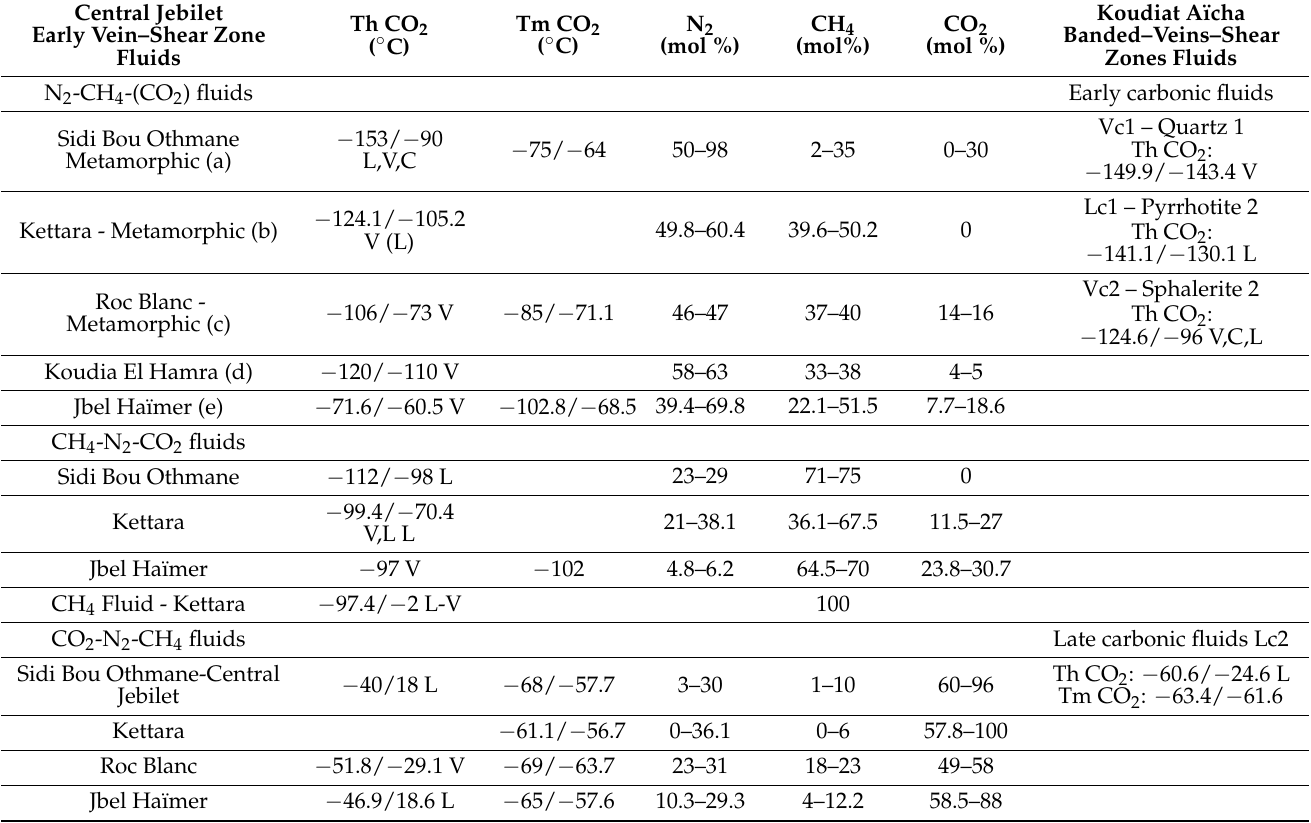
Table 5. Comparison of microthermometric data for fluid inclusions from early vein stages at Koudiat Aïcha (stage II) with data for C-O-N-H fluid inclusions from metamorphic veins in the Central Jebilet: a: [73]; b: [9]; c: [20]; d: [21]; e: [22]. Raman compositions of volatile phases for carbonic and aqueous–carbonic fluid inclusions in the Central Jebilet are given in mol %; Raman data are not available for Koudiat